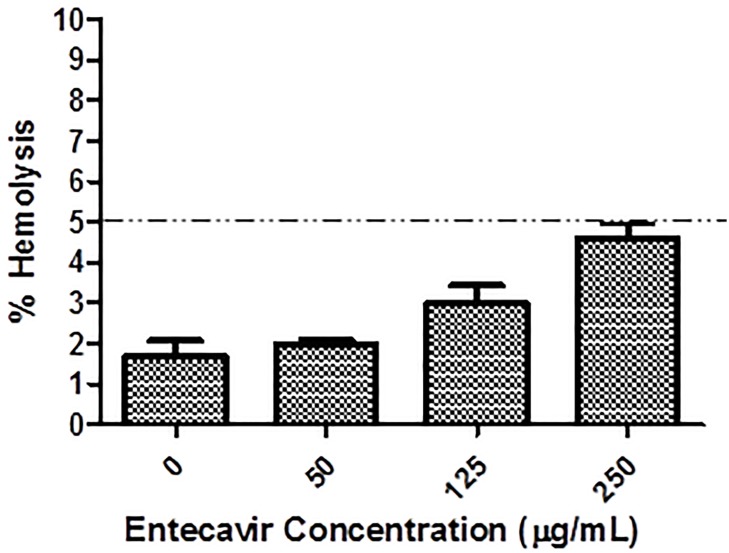
The in vitro hemolysis assay of EELPH.Rat RBCs were incubated with EELPH at different E concentrations (0–250 μg/mL) for 2 h at 37°C. Positive and negative controls were 0.5 w/v% Triton X-100 and PBS (pH 7.4), respectively. Samples were centrifuged at 4000 rpm for 5 min at 4 °C and the absorbance of the released haemoglobin was determined at 545 nm. Results are expressed as mean ± SD (n = 3). The dotted line represents the acceptable hemolysis range.